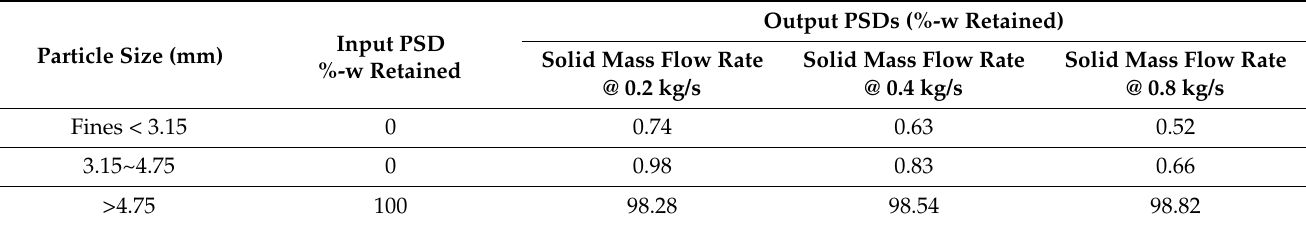
Table 5. Degradation of fresh pellets at an air flow rate of 0.27 kg/s with bends in proximity.